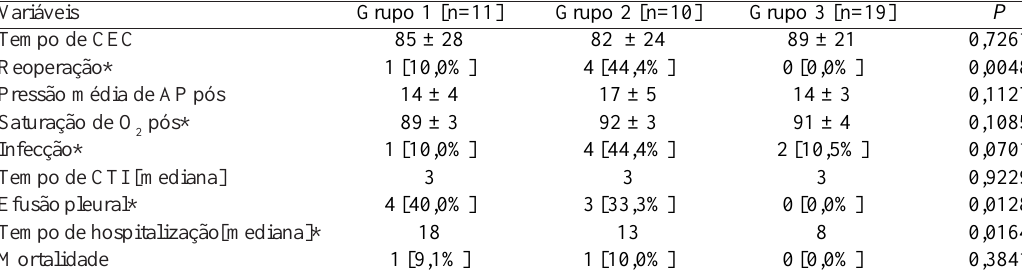
Tabela 3. Comparação das variáveis pós-operatórias nos três